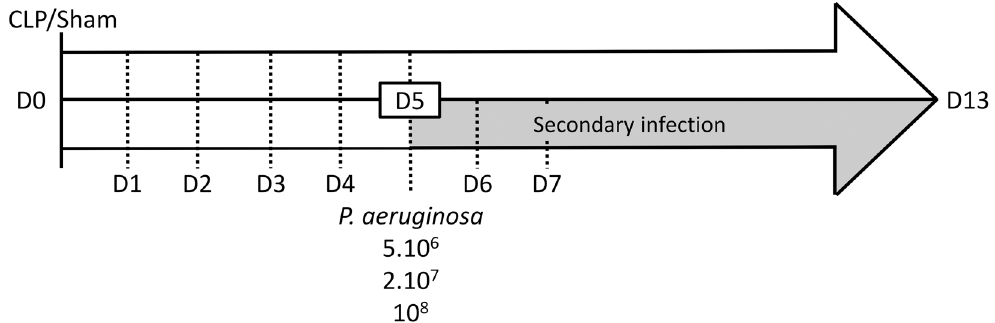
Fig 2. Study protocol. Mice were Sham- or CLP-operated at D0. Five days after surgery (D5), mice were or were not intratracheally instilled with P . aeruginosa . Plasmatic cytokines were measured at 2h, 6h, D1, D2, D3, D5 and D13 and also at D6 and D7 only for instilled